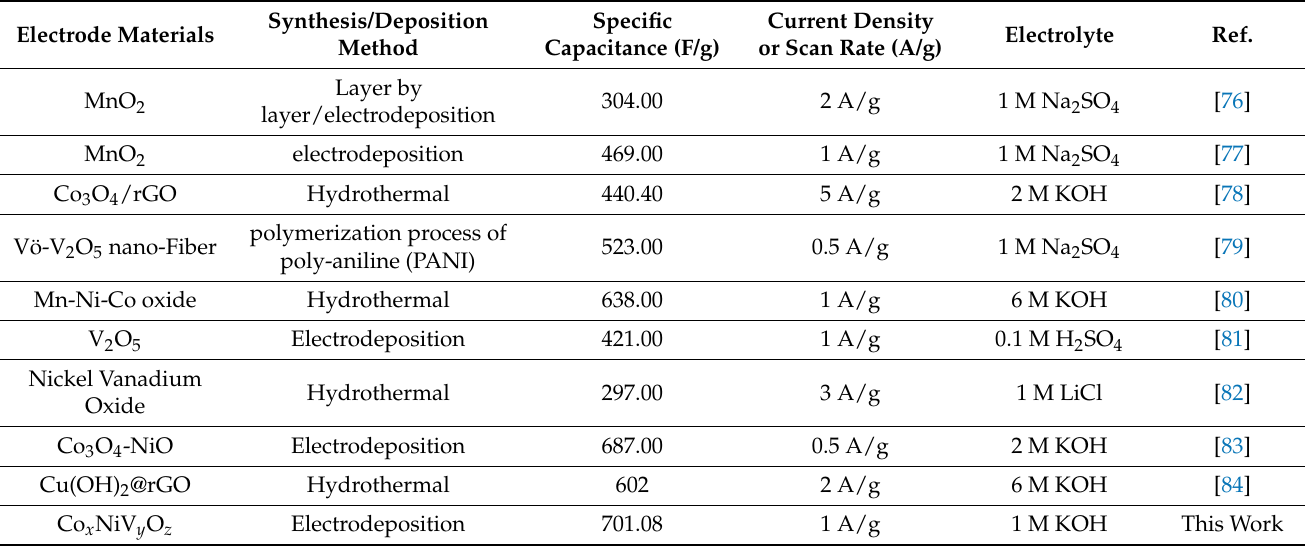
Table 2. Comparison between specific capacitance of the suggested electrode materials in the present research and similar reported references (all the reports used the Ni Foam as current collector).